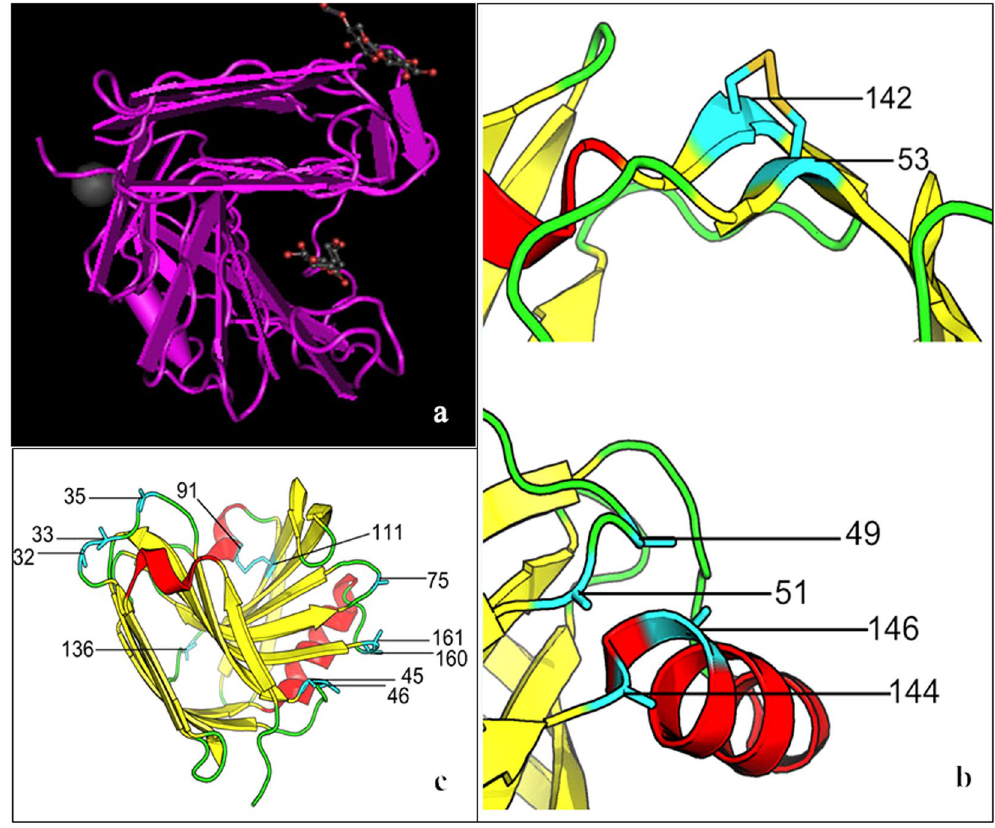
Figure 1. The positions of the designed disulphide bridges and proline substitution sites in Aspergillus sulphureus xylanase. ( a ) Model structure of xylanase (PDB 2QZ2_A) for the prediction of mutations. ( b ) The disulphide bridge at residue positions 53 and 142 is shown in blue; the β -sheets are shown in yellow; α -helixes are shown in red and the random coils are shown in green. The residue positions 49, 51, 144 and 146 are shown in blue. ( c ) The positions of introduced proline residues in A. sulphureus xylanase. The proline residues at sites 32, 33, 35, 45, 46, 75, 136, 160 and 161 are shown in blue, the β -sheets are shown in yellow, α -helixes are shown in red and the random coils are shown in green. The native disulphide bridge 92–111 of the wild-type xylanase is shown in